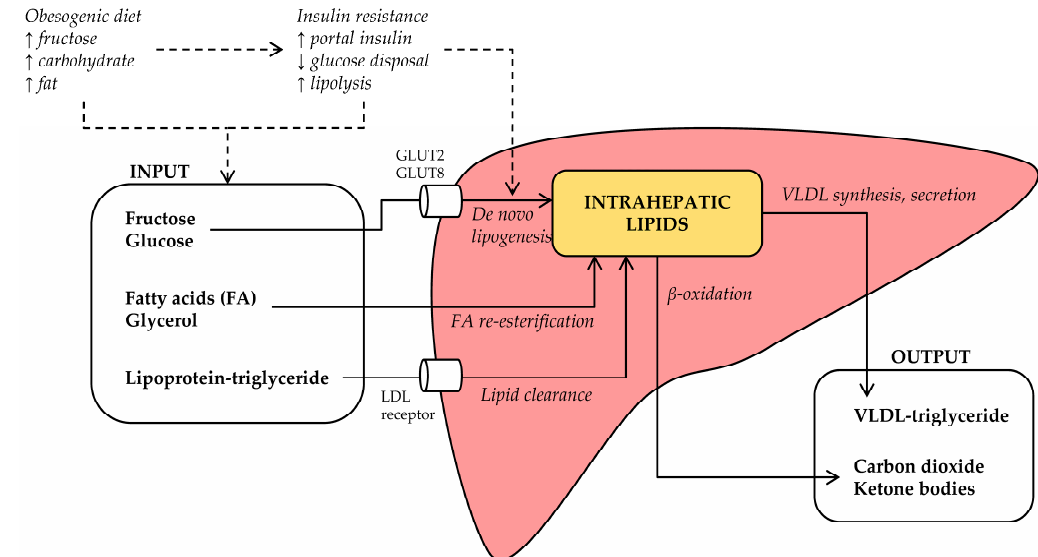
Figure 2. Hepatic steatosis develops when lipid input exceeds lipid output. Lipid input consists of (i) de novo lipogenesis from (primarily carbohydrate) precursors, (ii) re-esterification of lipolysis-derived fatty acids (FA) and glycerol, and (iii) low-density lipoprotein (LDL) receptor-mediated endocytosis of remnant-triglycerides. Lipid output consists of (i) β -oxidation and (ii) secretion of triglycerides in very low-density lipoprotein (VLDL) particles. Other abbreviation: GLUT2, glucose transporter 2; GLUT8, glucose transporter 8.